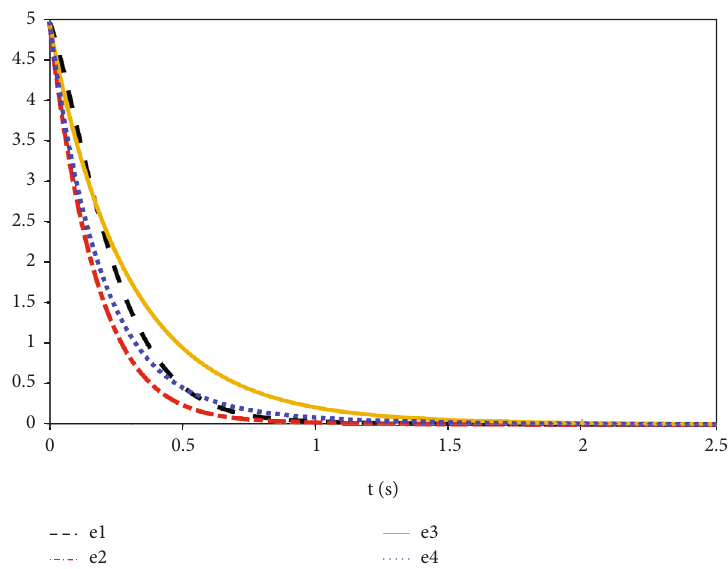
Figure 15: Graphs of the error dynamics (27).